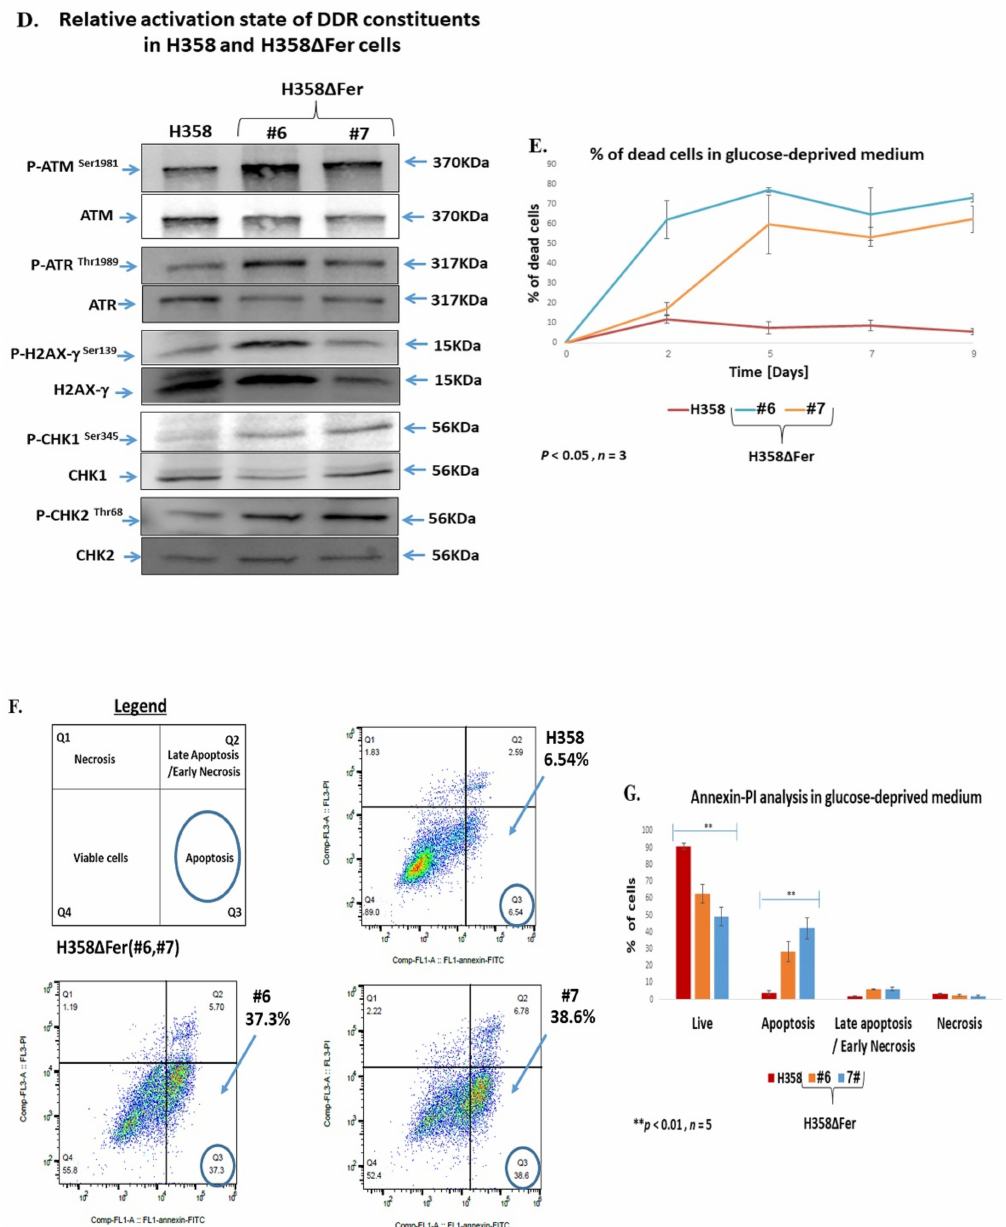
Figure 2. Elevated reactive oxygen species (ROS) levels, activation of DNA damage response (DDR), and onset of death, in metabolically challenged H358 ∆ Fer cells. ( A ) Dichlorofluorescein (DCF) staining indicating ROS levels determined using flow-cytometry analysis of cells grown under glucose-deprivation and glutamine-supplementation conditions. Profiles show one representative experiment out of four independent experiments that gave similar results. ( B ) Quantification of four independent ROS-determining experiments; results are presented as percent difference between H358 ∆ Fer and H358 cells. ( C ) In-situ immuno-staining of phosphorylated H 2 AX- γ (red) in the nuclei (blue) of parental H358 and H358 ∆ Fer cells. Scale bar: 10 µ m. ( D ) WB analysis depicting the relative activation state of DDR constituents in H358 and H358 ∆ Fer cells supplemented with glutamine in the absence of glucose. Results shown represent one out of three independent experiments which gave similar results. ( E ) Death curves of cells grown in glucose-free medium supplemented with glutamine was determined using the Trypan blue uptake-assay ( F ) Annexin-PI staining and FACS analysis determining the viability of cells grown under glucose deprivation and glutamine supplementation. Images represent one out of five independent experiments which gave similar results. ( G ) Average values were obtained from all five independent experiments. Results are presented as percentage of cells in each subpopulation. Histograms represent means +/ − SE. ** p -value <